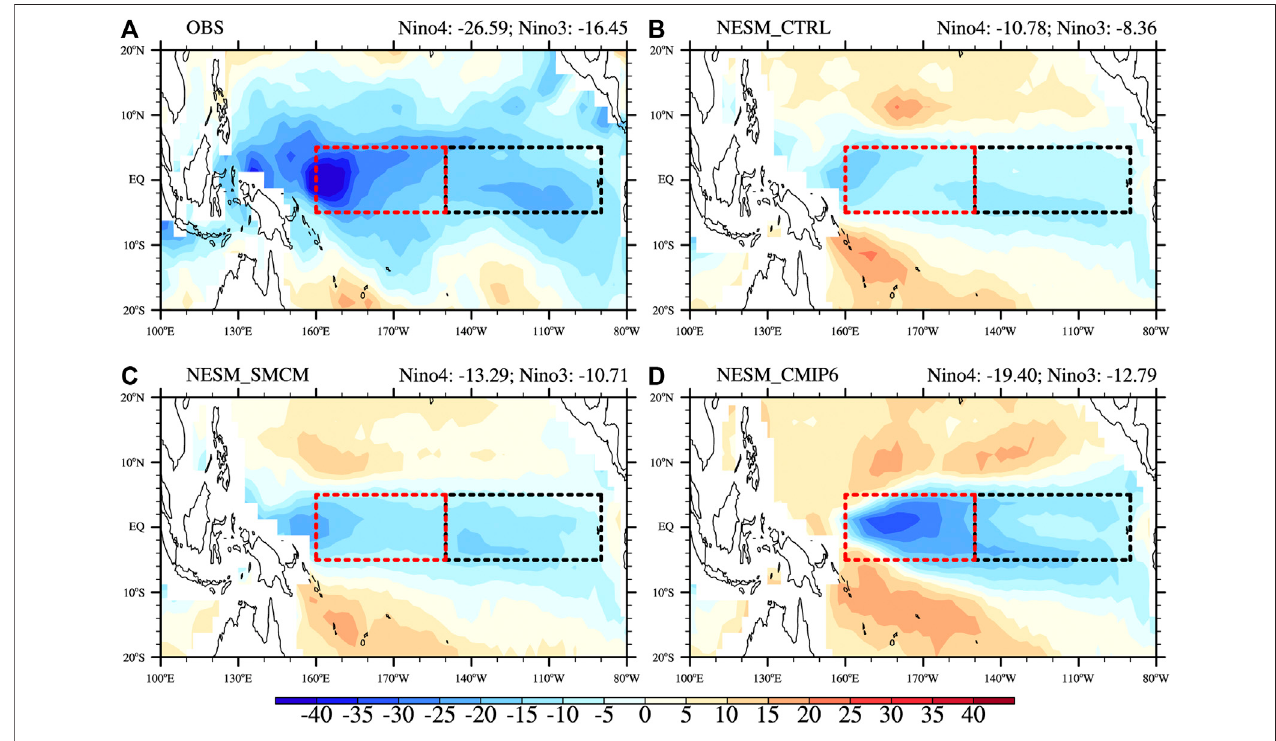
FIGURE 8 | Spatial patterns of the linear pointwise net surface heat fl ux regression (W m − 2 / ° C) against the SST in the tropical Paci fi c: (A) observations, (B) NESM_CTRL, (C) NESM_SMCM, and (D) NESM_CMIP6. Dashed red and black boxes in (A – D) denote the Niño-4 and Niño-3 regions, respectively.